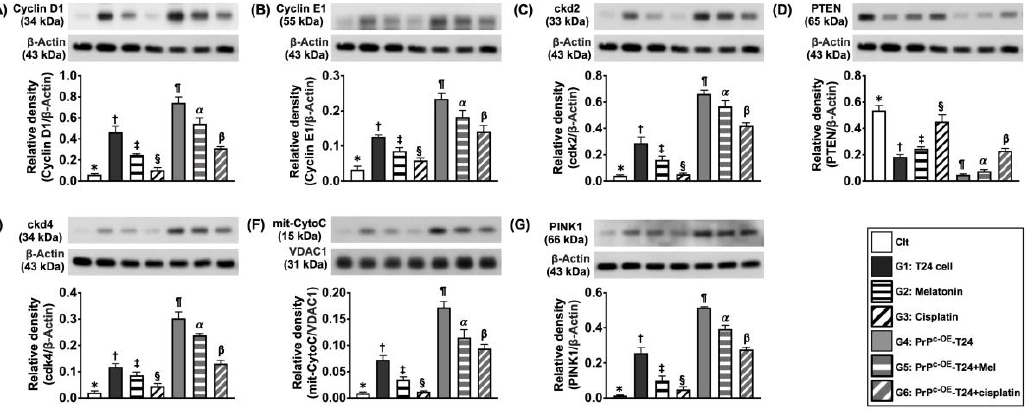
Figure 5. The protein levels of cell cycle signaling in different situations. ( A ) Protein level of cyclin D1: (1) * vs. different symbols (†, ‡, and §) and (2) ¶ vs. different symbols ( α and β ), all p values <